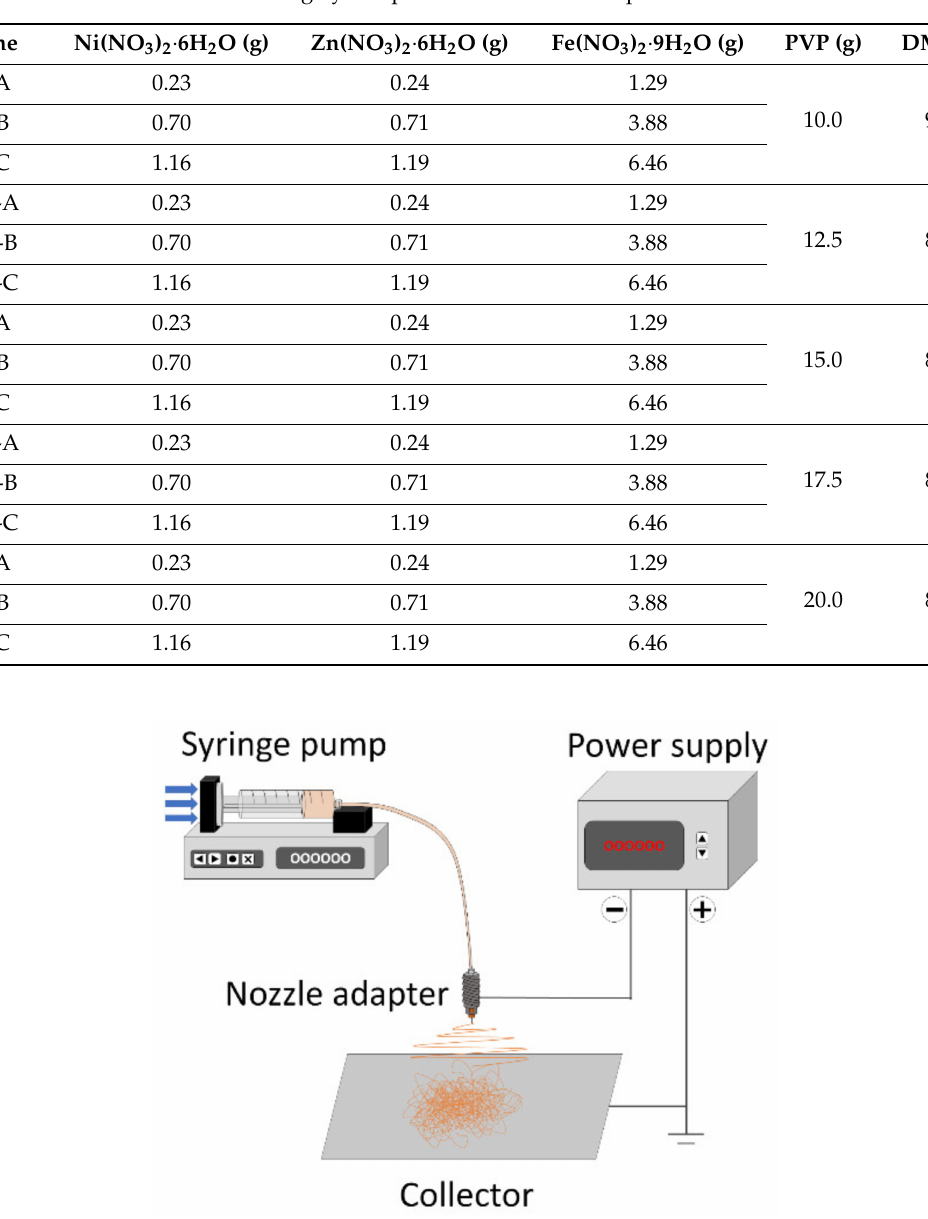
Figure 1. Scheme of the electrospinning equipment